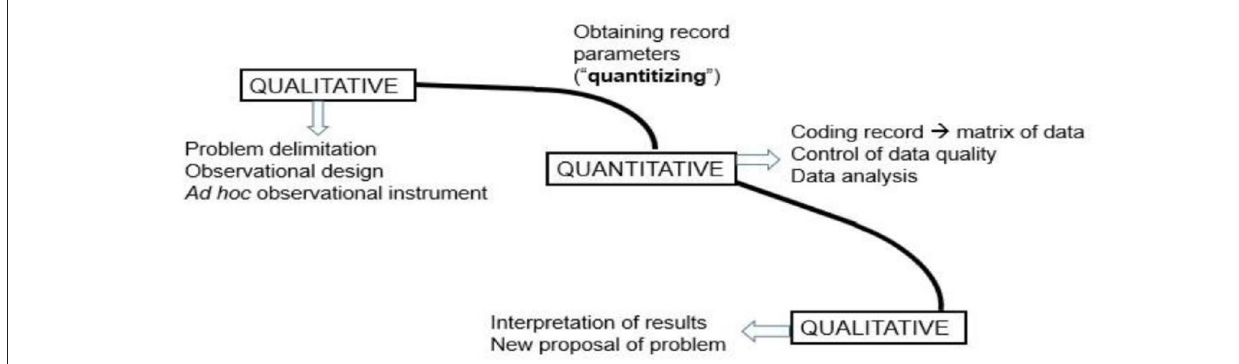
FIGURE 3 | Macro steps of systematic observation process: QUAL-QUAN-QUAL.